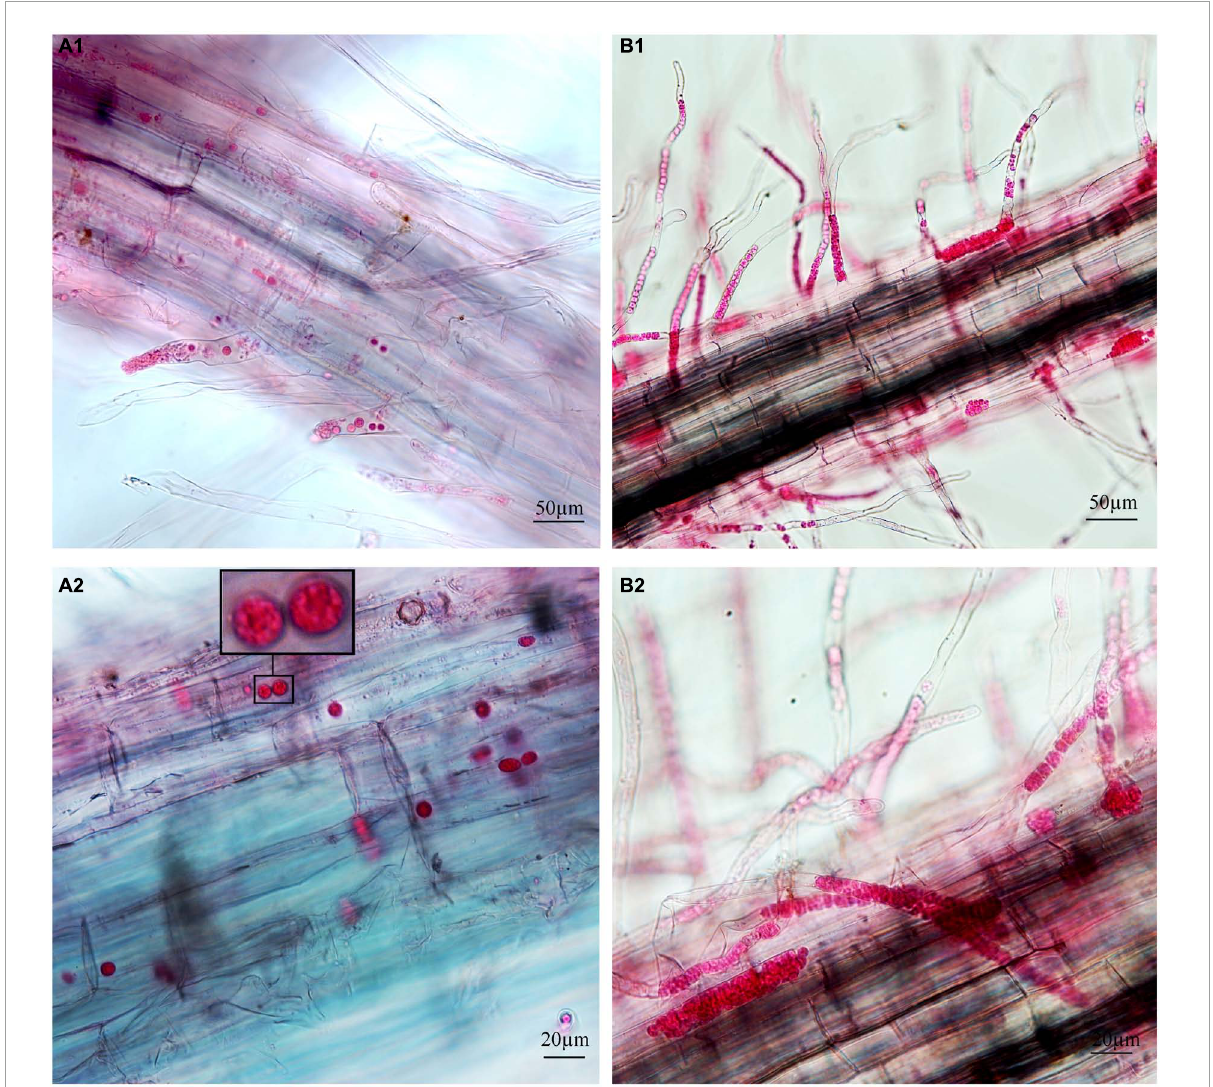
FIGURE2 Infection of cabbage after inoculation with secondary zoospores. (A1,A2) Images of secondary zoospore inoculation after 7 days. (B1,B2) Images of secondary zoospore inoculation after 12